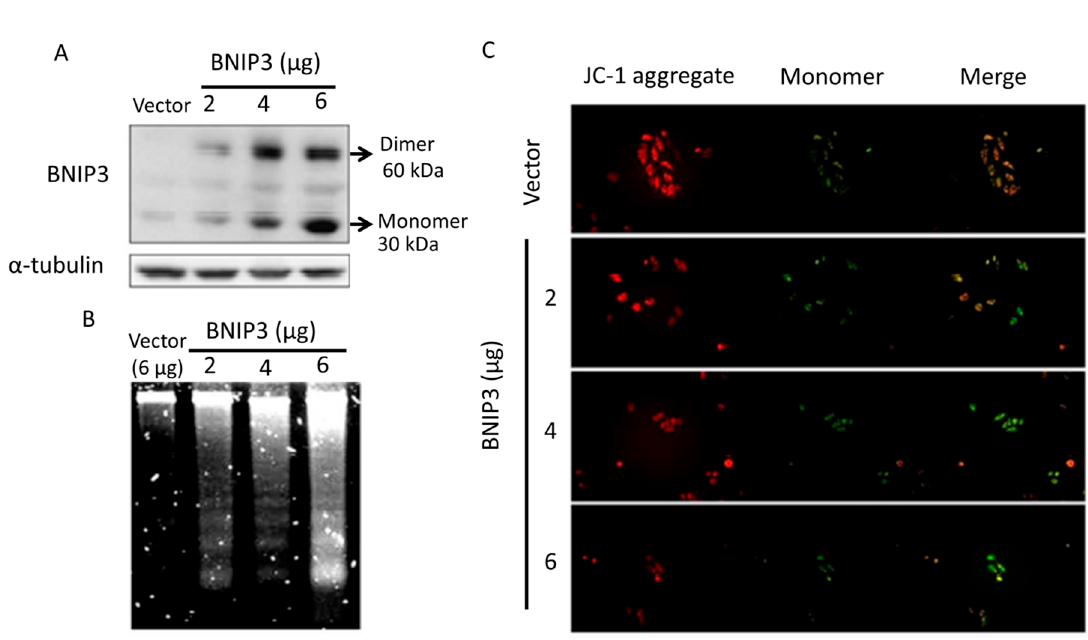
Figure 1. BNIP3 overexpression induces H9c2 cardiomyoblast cell apoptosis. H9c2 cells were transfected with differing amounts (2, 4, 6 μ g) of BNIP3-containing plasmids for 24 h. Cells were harvested for different assays. ( A ) Western blot showed that BNIP3 protein expression increased in a dose-dependent manner; ( B ) The degree of DNA fragmentation increased in proportion to the level of B-cell lymphoma 2 (BCL2)/adenovirus E1B 19 kDa (BNIP3) expression; ( C ) JC-1 stain presented mitochondria integrity. The merging of normal ( red ) and damaged ( green ) mitochondria represented the integrity ratio. We found that there was a significant fluorescence emission shift from red to green in cells that overexpressed BNIP3, indicating that BNIP3 overexpression led to mitochondrial damage and DNA fragmentation and, hence, activation of the apoptotic pathway.